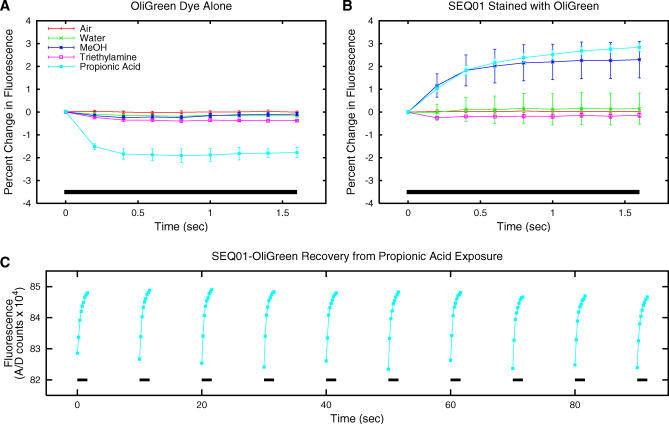
Changes in Fluorescence from ssDNA and OliGreen Dye Sensors during Short Odor Sniffs(A) Responses of a sensor made from OliGreen alone.(B) Responses of a sensor made from 20 μl of 10 μM oligomer SEQ01, stained with OliGreen.(C) Responses from SEQ01 to 10 repeated applications of 10−1 propionic acid (∼390 ppm), demonstrating return to baseline between sniffs. These 10 responses were used to calculate the mean shown in (B). See Figure 1 for details of odor presentation, odor dilutions, and description of data representation.